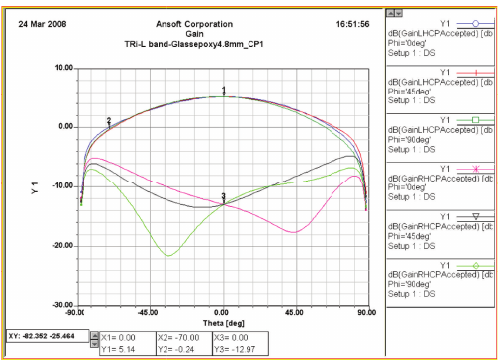
Figure 5: Gain radiation pattern.